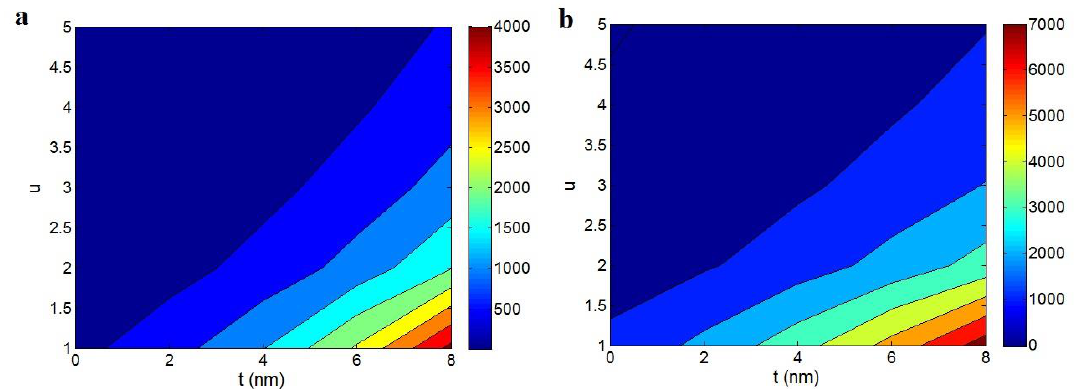
Figure 5. The electrical conductivity of PCNT at different “t” and “u” values according to ( a ) conventional model (b = 2, Equation (9)) and ( b ) developed equation (Equation (12)).